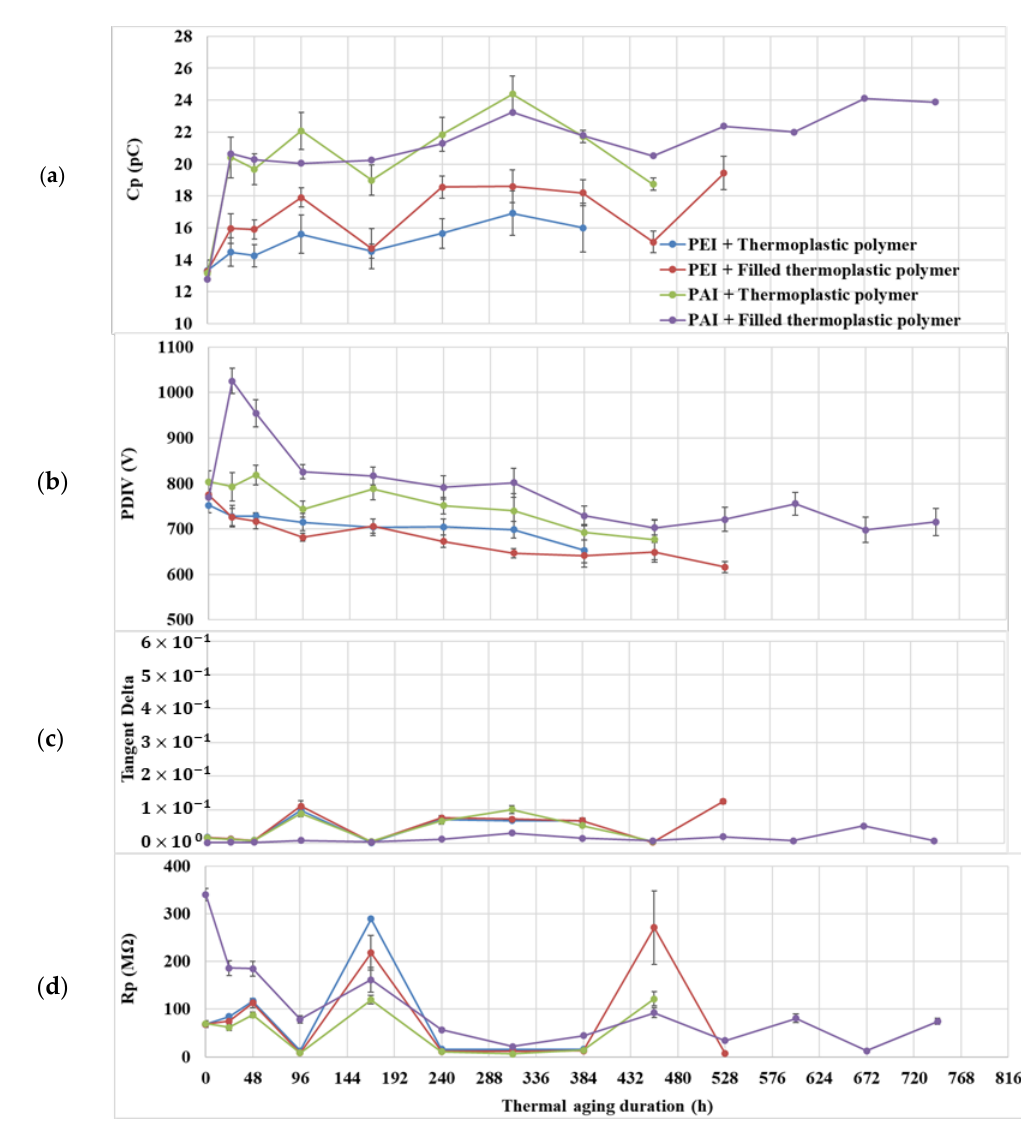
Figure 9. Mean values of dielectric parameters collected during the thermal aging test at 250 °C. ( a ) Parallel capacitance (Cp). ( b ) Partial discharge inception voltage (PDIV). ( c ) Dielectric loss factor (tangent delta). ( d ) Parallel resistance (Rp).